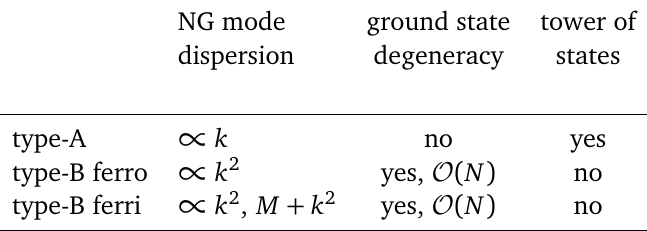
Table 3.1: Properties associated with different types of Nambu–Goldstone modes. The accurate forms of the dispersion relations can be found in Eqs. 3.19.